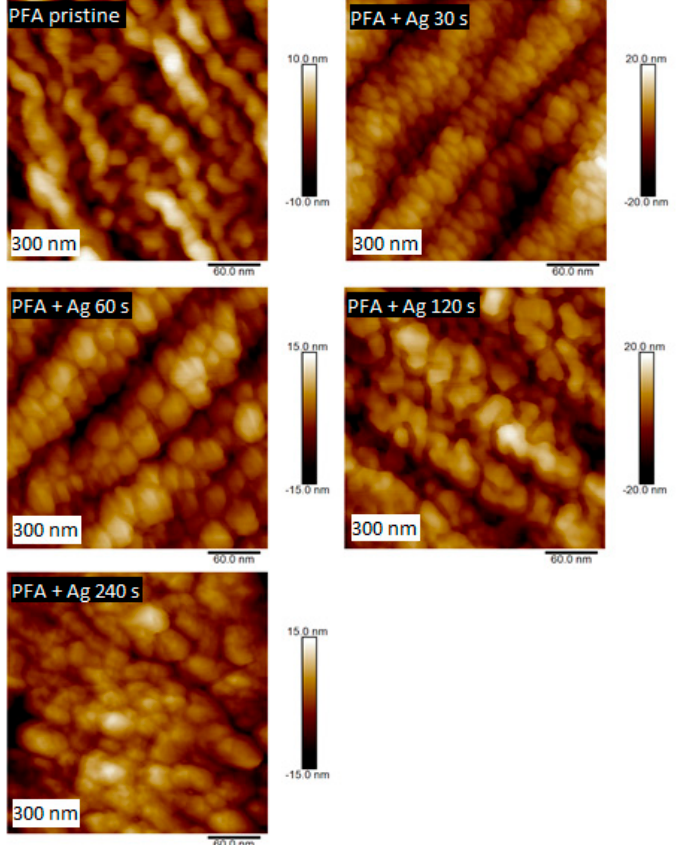
Figure 4. Surface morphology studied by AFM for pristine PFA and PFA deposited with Ag for 30, 60, 120, and 240 s (scan of 300 × 300 nm 2 ). The second set of PTFE samples was modified by plasma at 3 and 8 W power outputs and exposure time of 60, 120, and 240 s. The dependence of the shape of the surface struc- tures on the plasma power and exposure time was studied. Significant changes in surface structures were observed already after sample modification with low power of 3 W. In Figure 5, the surface structures of the plasma-modified samples are compared with an unmodified PTFE sample. It is apparent that plasma exposure had a significant effect on the surface structure of PTFE (see Figure 5). The sample modified for 60 s did not show a significant change in surface morphology; however, at longer exposure times, a change in the shape of the surface structures was observed; more specifically, a division into smaller surface nanocluster units occurred. Next to the PTFE samples, PFA substrates were also studied to determine the effect of argon plasma on the surface structure. Comparison of these two substrates is made based on the similarity of surface chemistry; however, morphologically, they are two dif- ferent types of materials: a foil (PFA) and nanotextile (PTFE), which will be further noted especially for PFA in AFM analysis.